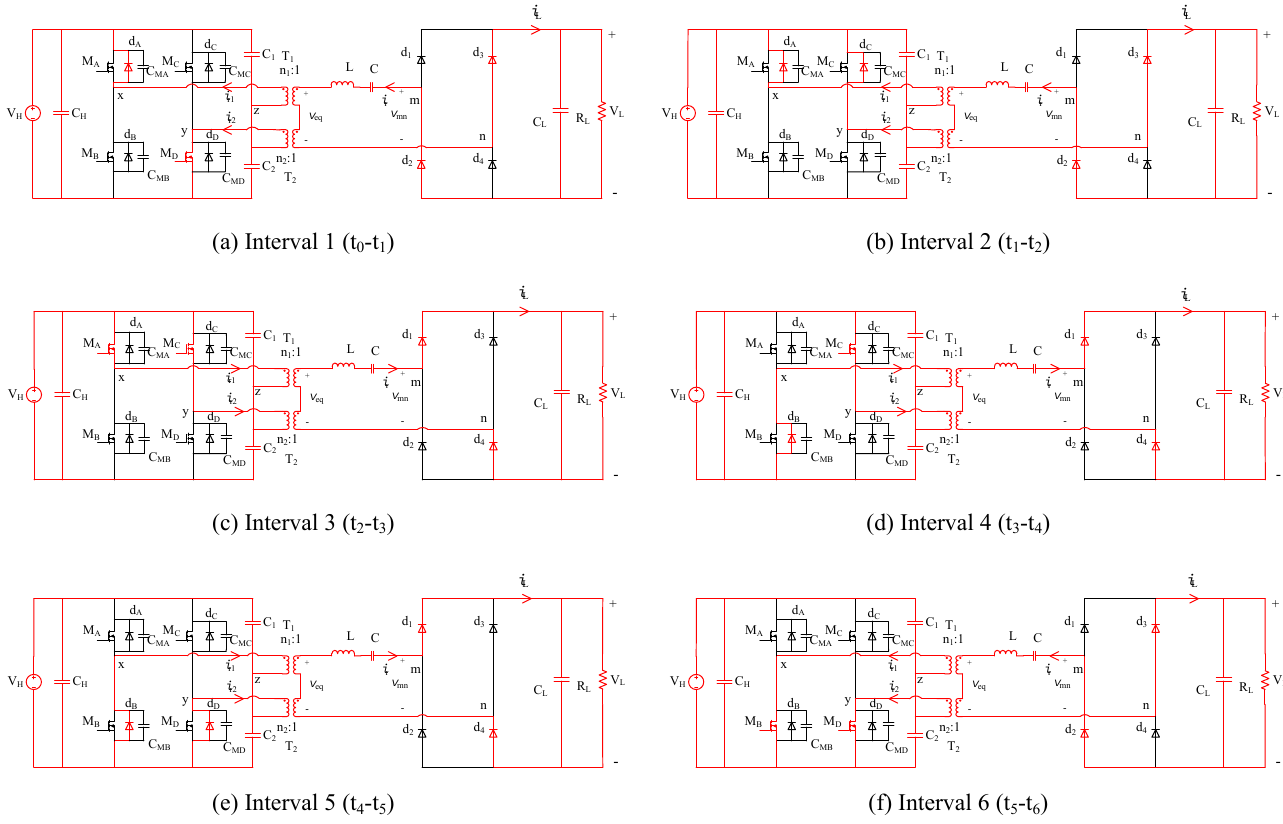
Figure 3. The equivalent circuits during different intervals of